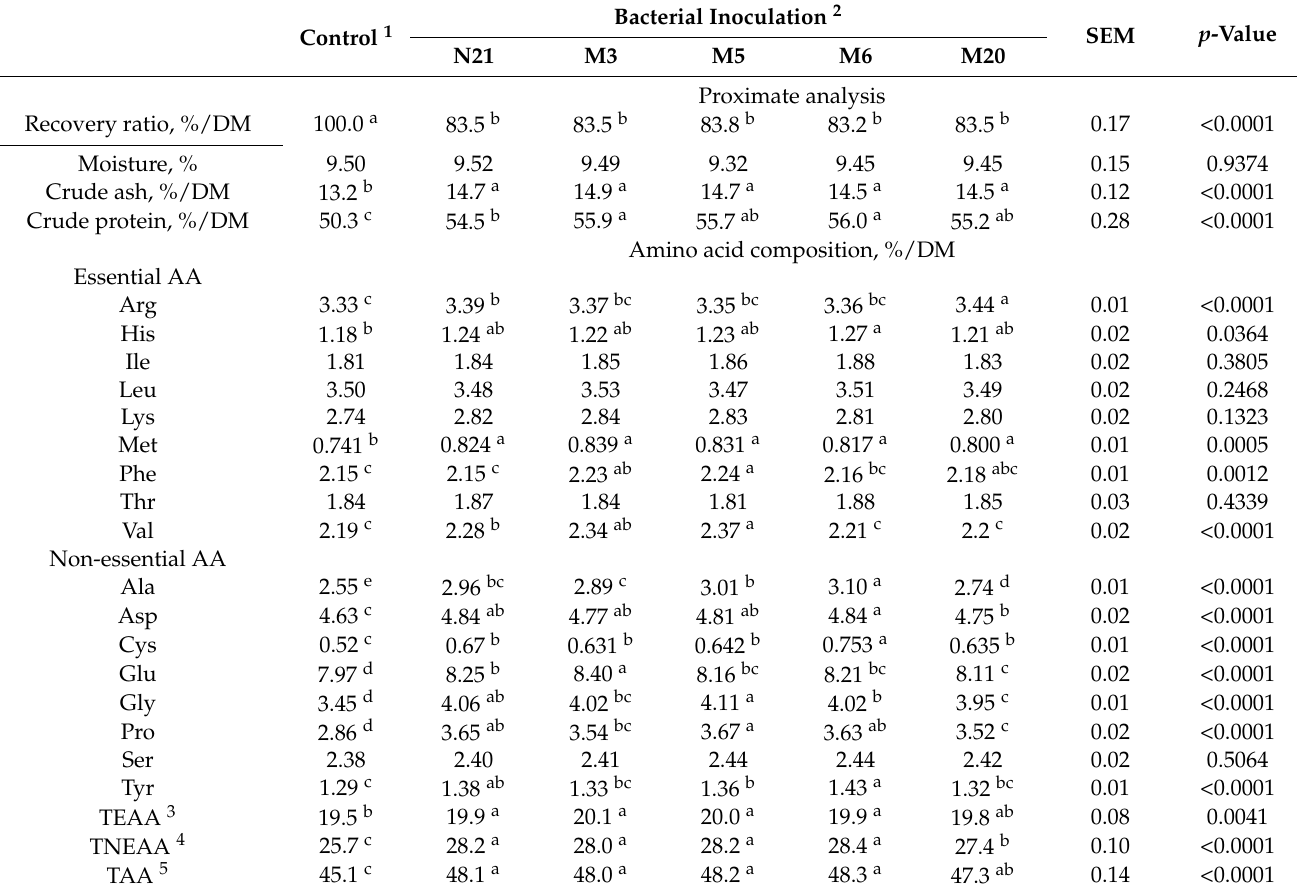
Table 5. Results of proximate analysis and amino acid composition for different FMSMPs. Control